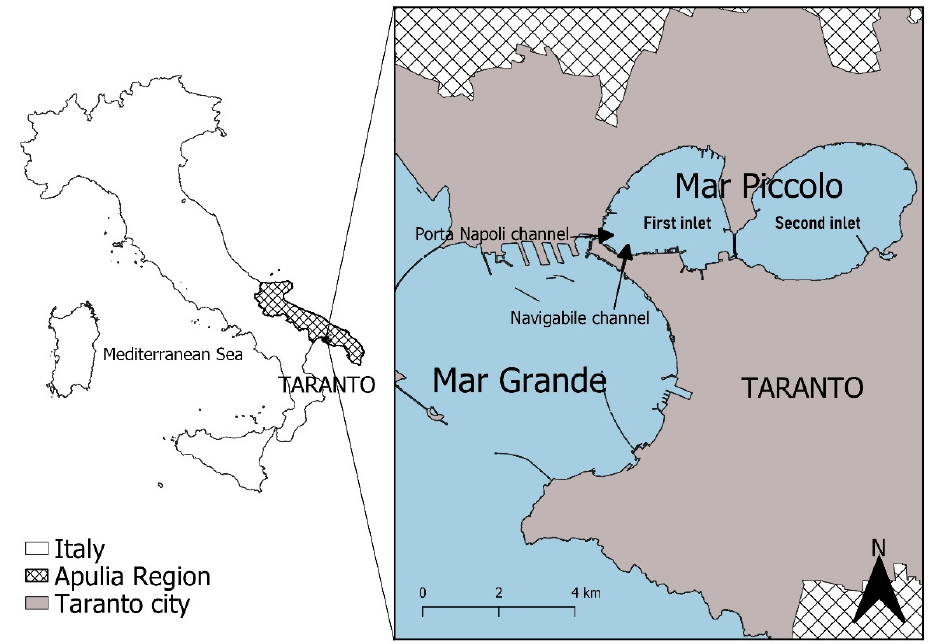
Figure 1. Study area.